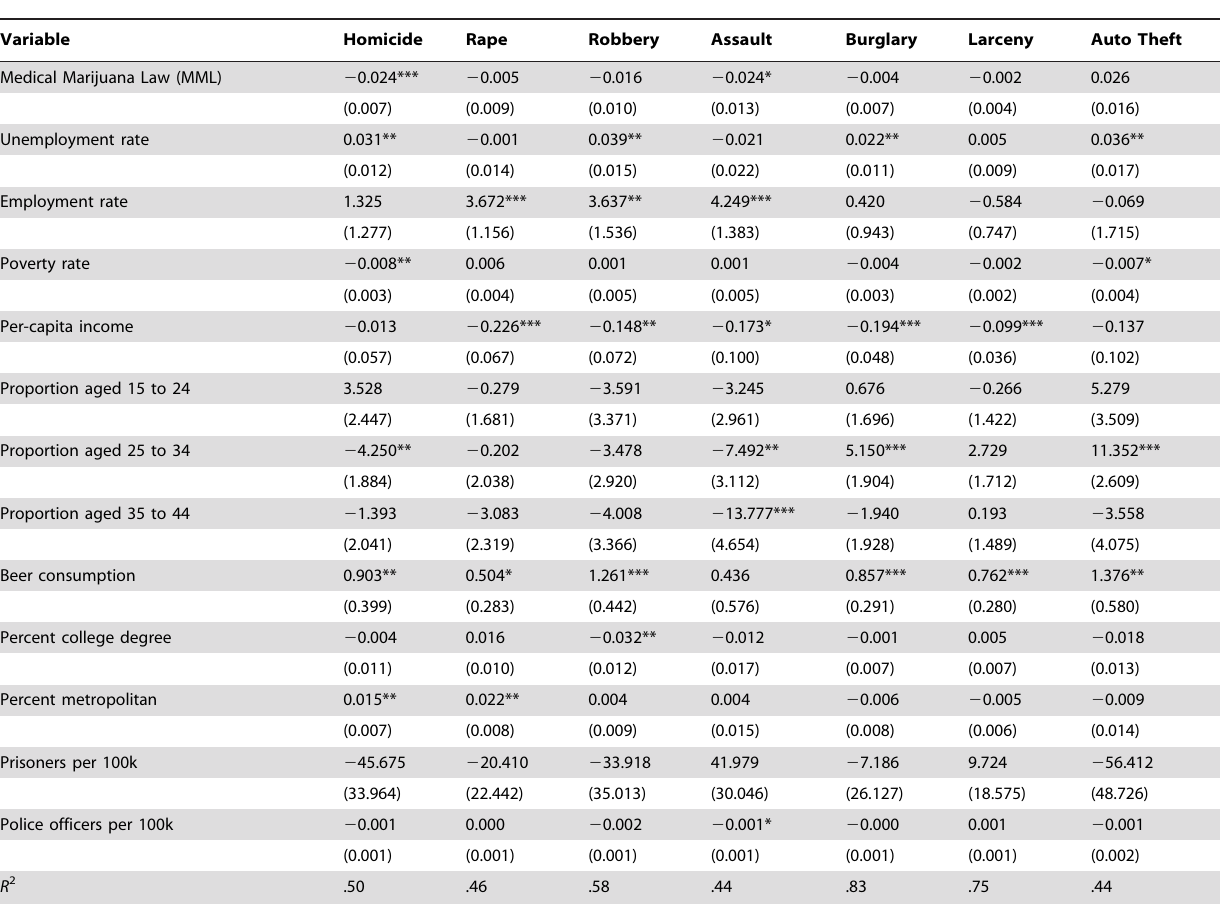
Table 2. The Impact of Medical Marijuana Laws on Crime